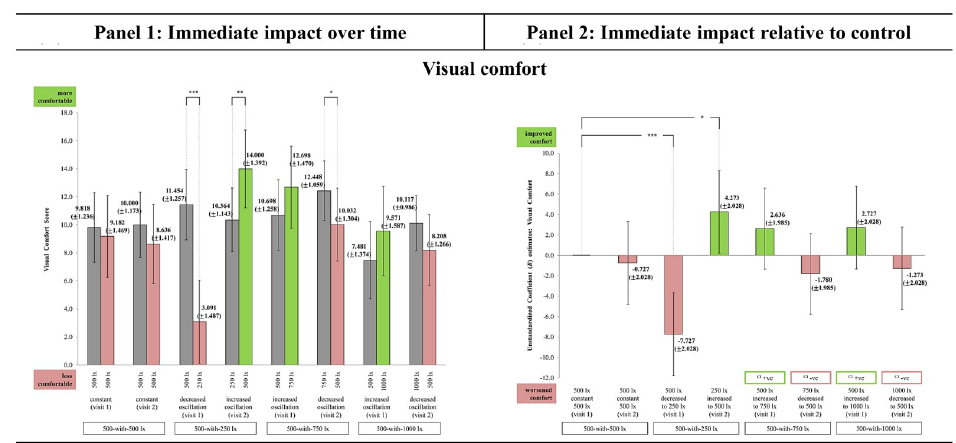
Fig 9. The immediate impact observed in Visual comfort across the light-settings. (Panel 1) Immediate change over time in all light-settings: Bars represent Estimated Marginal Means (EMM) with Standard Errors (SE); whiskers 95% confidence interval (CI); ��� p < 0.001, �� p < 0.01, � p < 0.05, ^ p < 0.06. Dark grey bar specifies EMM at TP 1 . Green bar specifies EMM at TP 2 (supportive change). Red bar specifies EMM at TP 2 (unsupportive change). (Panel 2) Immediate impact of each light-setting relative to control: Bars represent Unstandardized Coefficient ( B ) with Standard Errors (SE); whiskers 95% CI; ��� p < 0.001, �� p < 0.01, � p < 0.05, ^ p < 0.06. Green bar specifies light-setting as more supportive than control. Red bar specifies light-setting as less supportive than control. (S2 Fig) The chronological order of each light-setting’s EMM Δ for visual comfort. It is recommended to be referred along with Fig 9 to improve the comprehension between panel 1 and 2. Light-setting with EMM Δ chronologically ordered above than the control (S2 Fig) corresponds with the direction of the B estimate bar as being more supportive than control (Fig 9, panel 2).